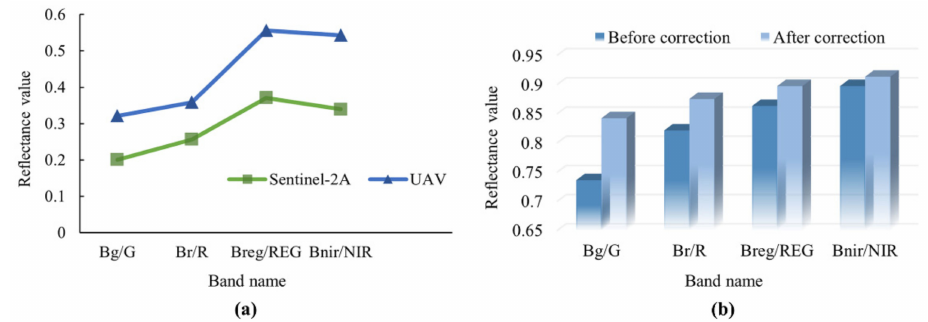
Figure 7. ( a ) Comparison of reflectivity between UAV multispectral imagery and Sentinel-2A satellite imagery. ( b ) Correlation between UAV multispectral imagery and reflectivity of Sentinel-2A imagery before and after correction.